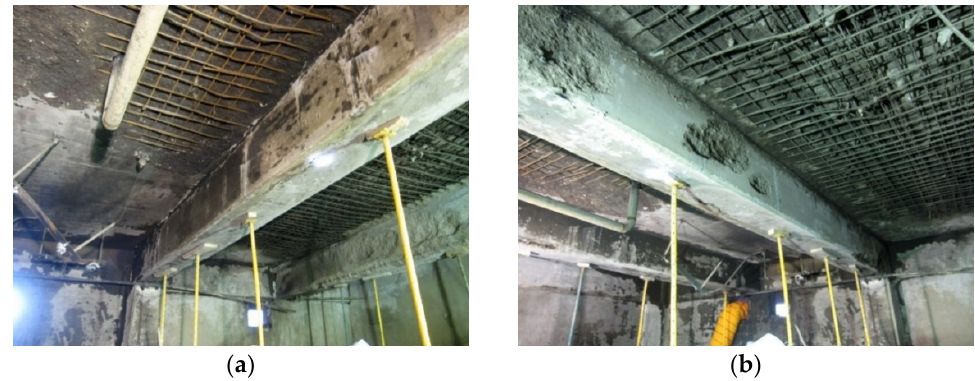
Figure 6. Damage to Girder #2. ( a ) East side of girder seen from the north. ( b ) West side of girder seen from the north.